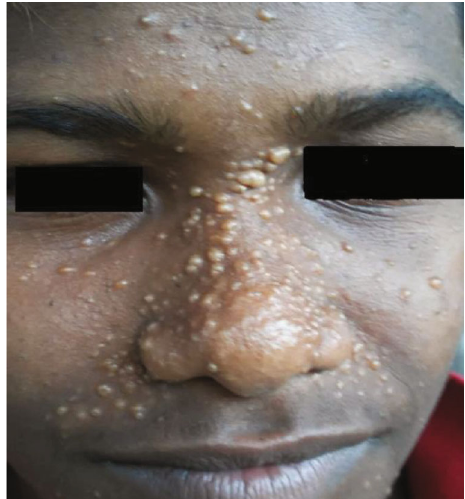
Figure 2: Patient ’ s mother with multiple facial papules relatively larger in size and extensively distributed over the entire